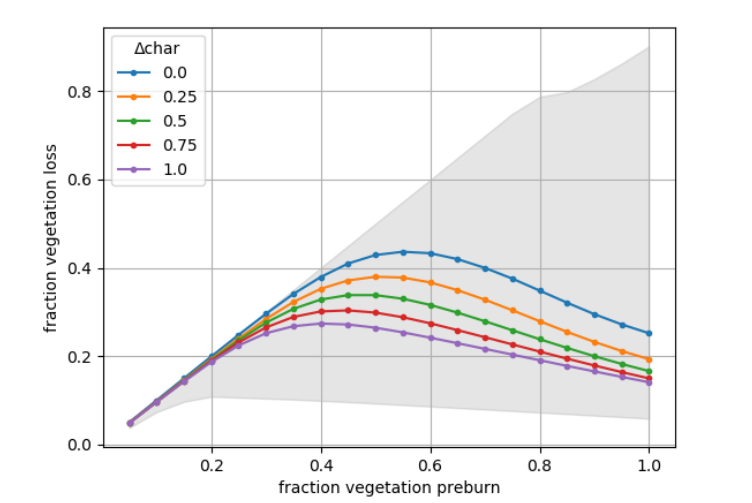
Figure 8. Vegetation loss results depending on starting vegetation fraction and ∆ char parameter setting, park-wide for Landsat 8, dNBR threshold = 0.15. Mean values are shown in colored lines, with total model result variation shown in